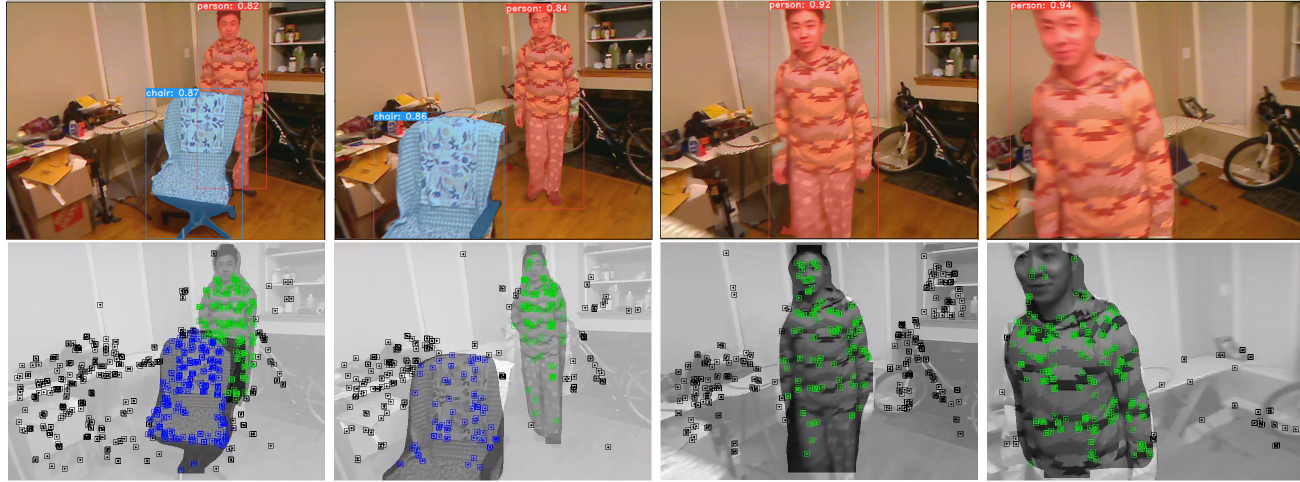
Figure 2. A scene with multiple moving objects. The first row shows the original frames with the semantic masks from YOLACT [45], and the second row shows the tracking result from DOE-SLAM. There are two moving objects: an armchair and a